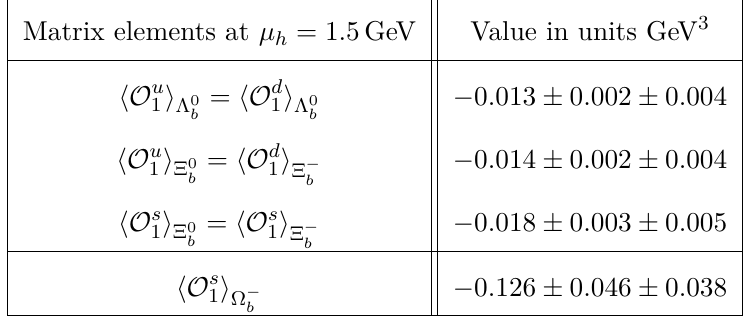
at the scale µ h = 1 . 5 GeV, 1